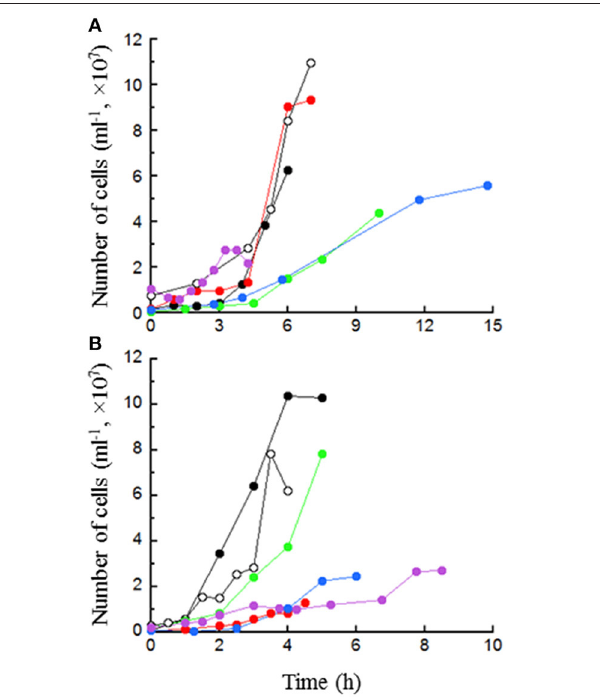
FIGURE 6 | Growth of T. paralvinellae (A) and P. furiosus (B) in the 20-l bioreactor in 0.5% maltose ( • ), 0.5% tryptone ( • ), 0.5% maltose + 0.05% tryptone ( ◦ ), 0.5% maltose + 10mM acetate ( • ), 0.5% maltose at pH 5.0 ( • ), and 0.1% waste milk ( • ). Data are examples from individual bioreactor